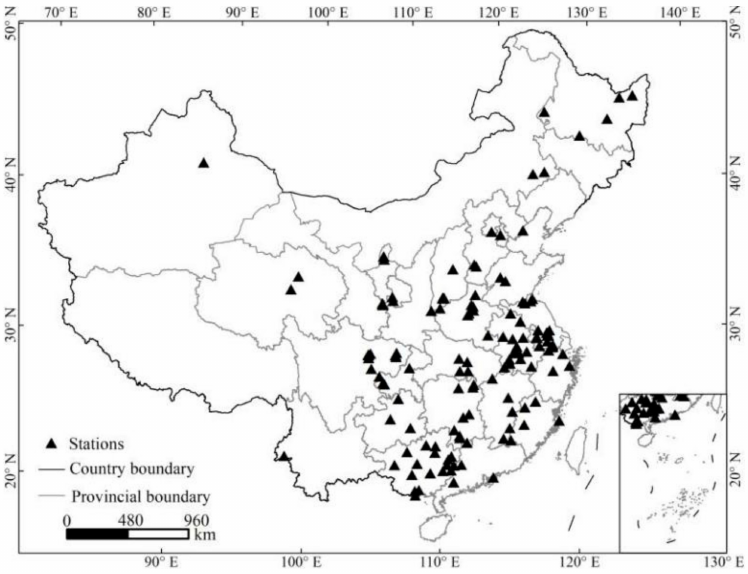
Figure 1. Spatial distribution of experimental sites from SDMI application compiled in